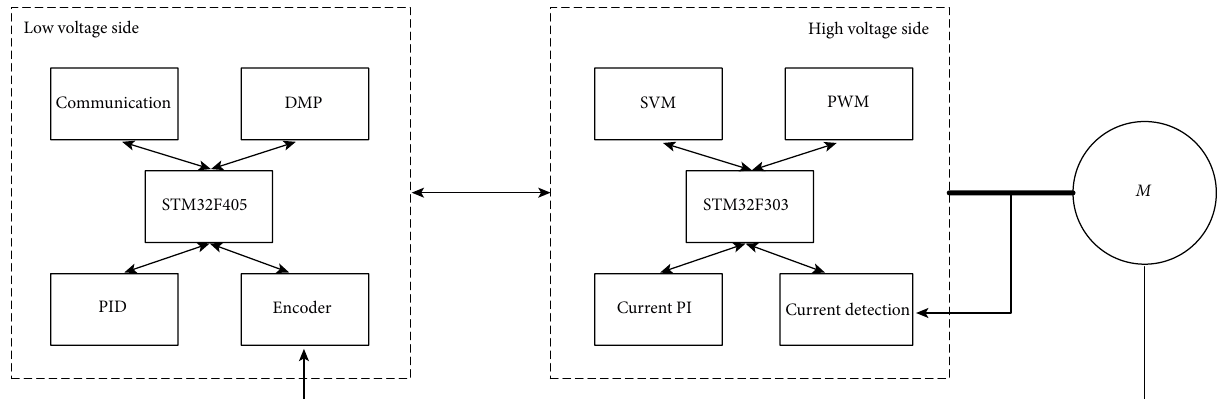
Figure 11: Function module of joint motor